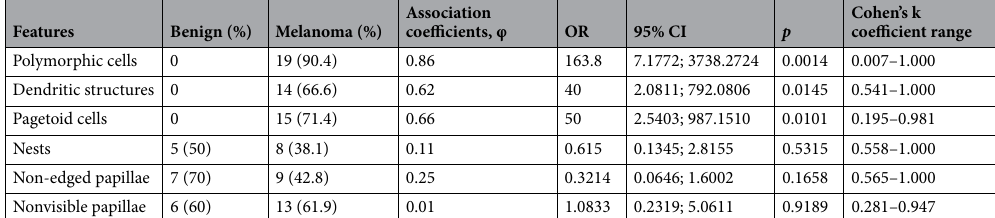
Table 1. Frequency of MPM malignant features in benign nevi (n = 10) and invasive melanomas (n = 21).